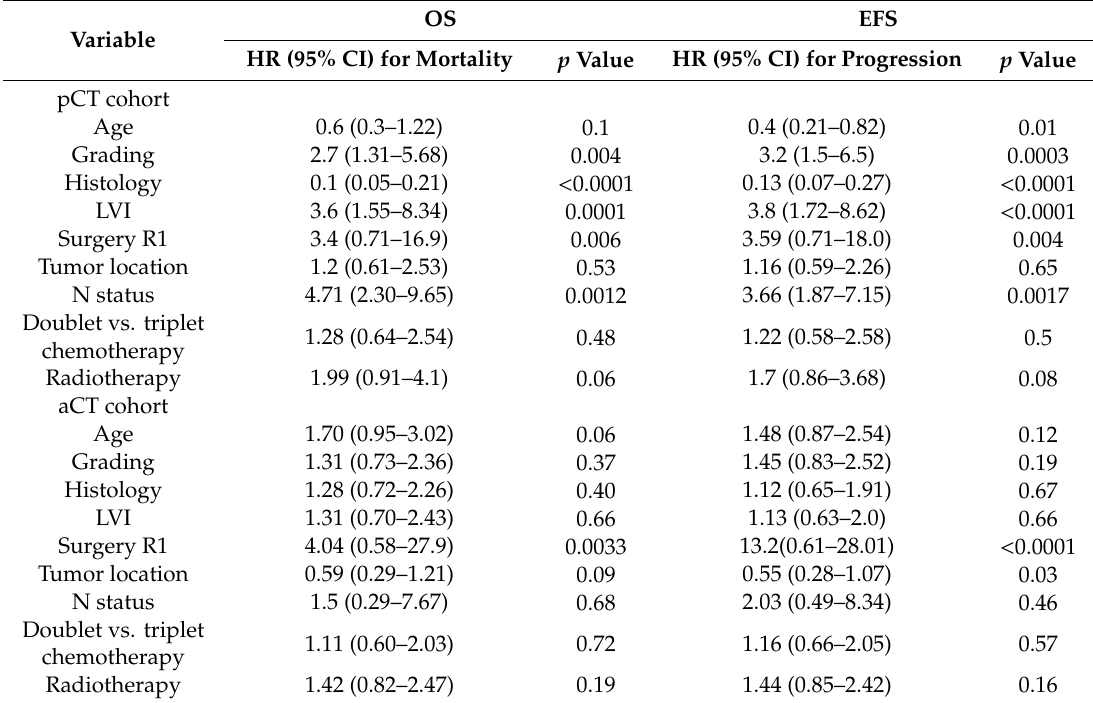
Table 2. Univariate Analysis of OS and EFS for Clinicopathologic Variables in pCT and aCT Cohort.